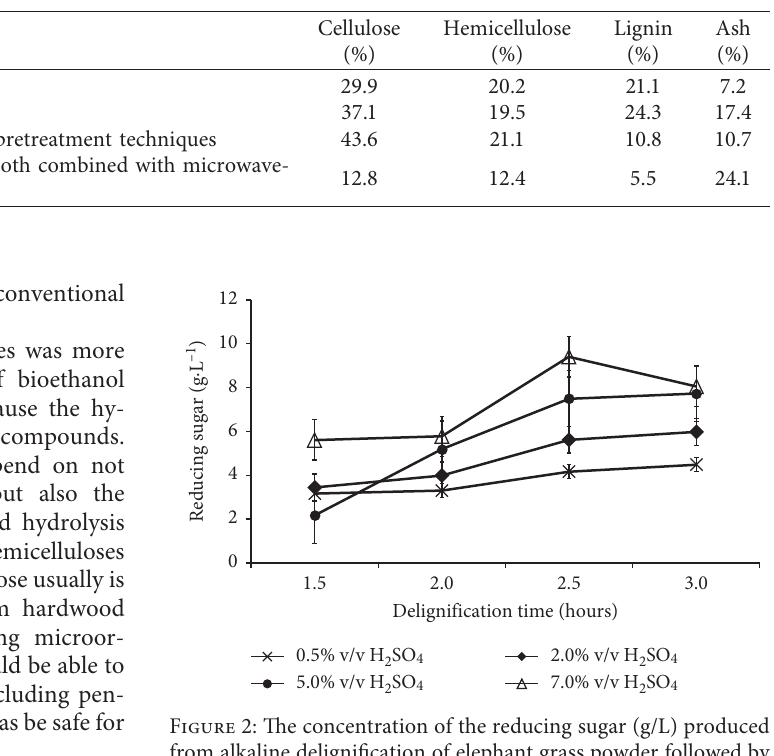
Table 2: The lignocellulose content of the elephant grass powder a .